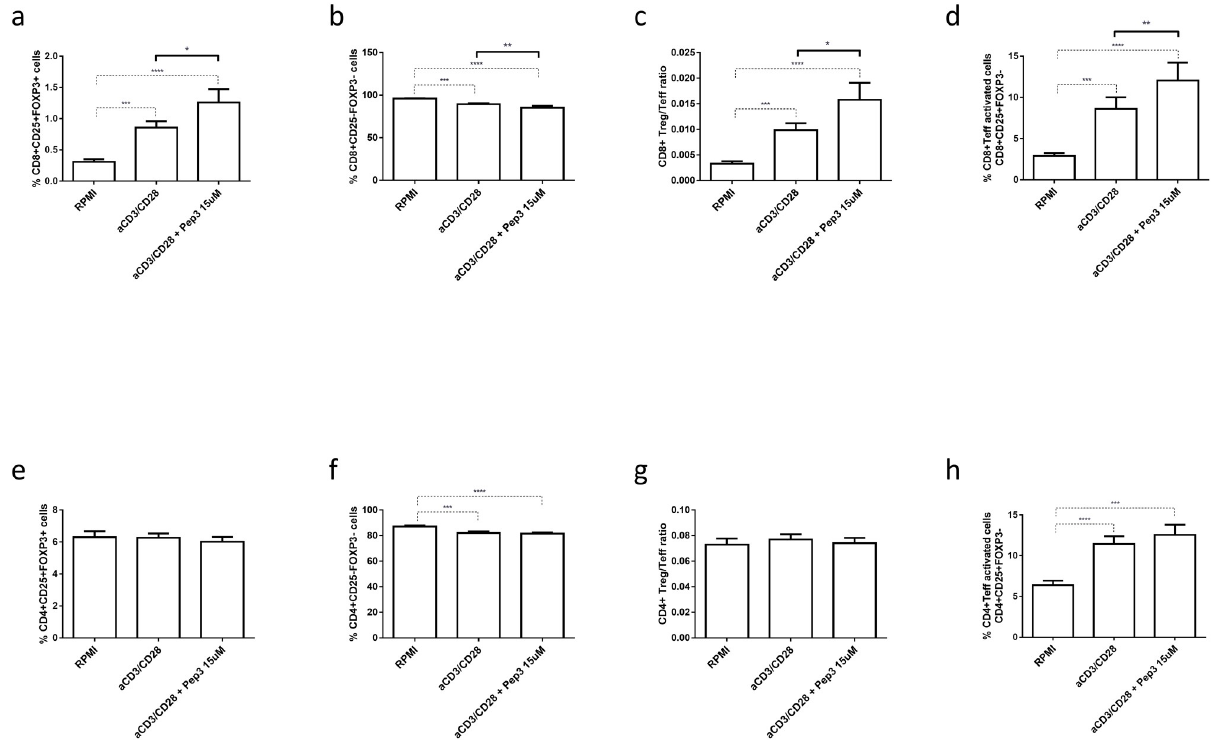
Fig 4. Frequency of T cell populations relative to type 1 diabetes PBMC upon treatment with peptide 3 and subsequent stimulation with anti- CD3/CD28 beads for 6 days. Flow-cytometry analysis of type 1 diabetes PBMC following Pep3 15 μ M treatment and subsequent stimulation for six days with anti-CD3/CD28 beads. Graphs show the percentage of CD8+ Treg as CD8+ CD25+FOXP3+ cells ( a ), CD8+ Teff as CD8+ CD25-FOXP3- cells ( b ), CD8+ Treg/Teff ratio ( c ), CD8+ Teff activated cells as CD8+ CD25+FOXP3- cells ( d ), CD4+ Treg as CD4+ CD25+FOXP3+ cells ( e ), CD4+ Teff as CD4+ CD25-FOXP3- cells ( f ), CD4+ Treg/Teff ratio ( g ), CD4+ Teff activated cells as CD4+ CD25+FOXP3- cells ( h ). Values correspond to mean frequency ± SEM of 16 LT type 1 diabetes patients. � p < 0.05, �� p < 0.01, ��� p < 0.001, ���� p < 0.0001. Percentages were obtained as described for the previous experiments (see legend to Fig